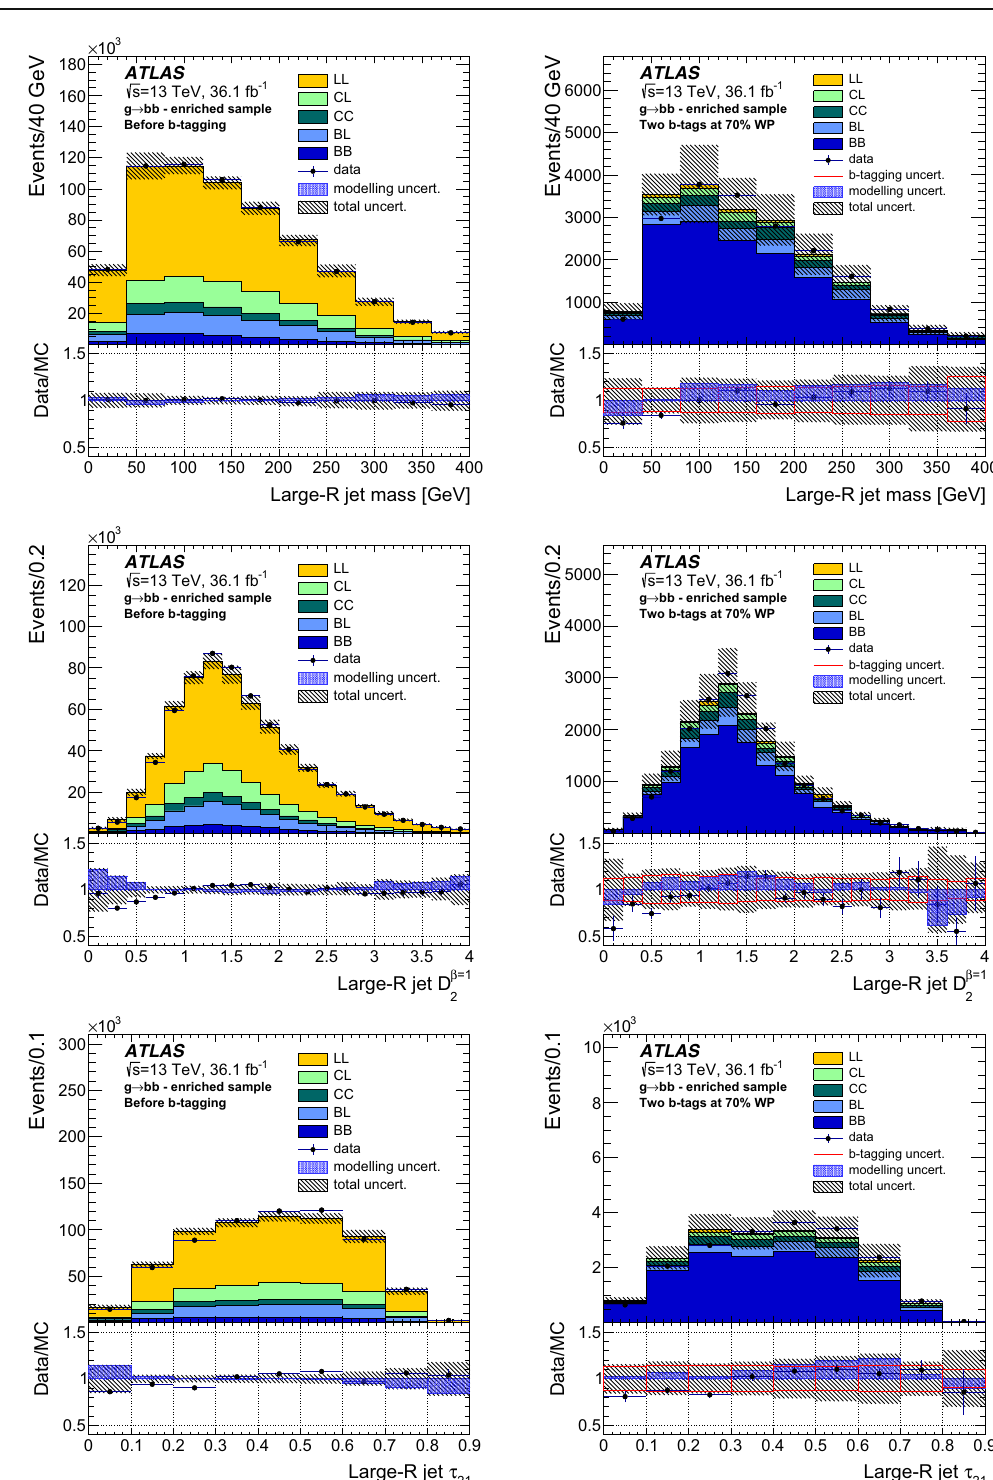
β = 1 and τ 21 uncer- 2